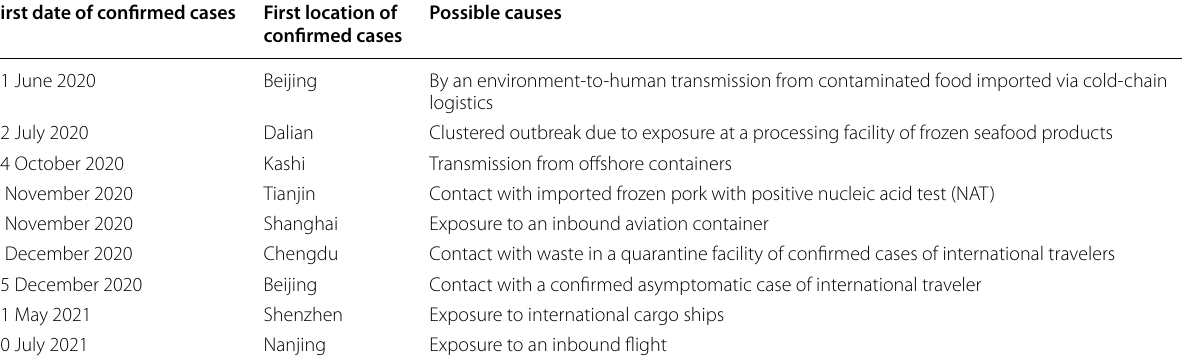
Data source: The official websites of China’s provincial and municipal health commissions or press conferences on epidemic prevention and